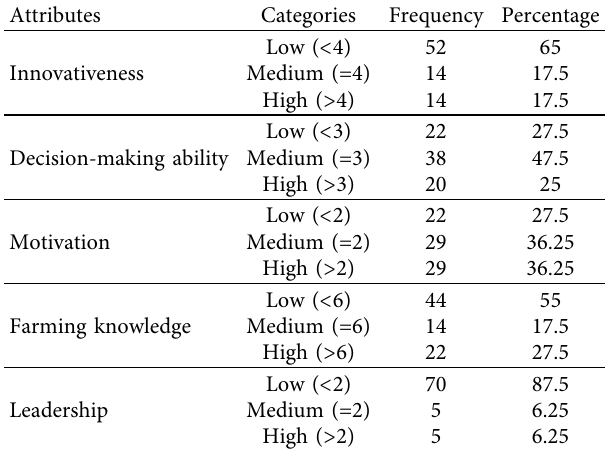
Table 2: Entrepreneurial behavior of indigenous fish farmers in Eastern Chitwan,